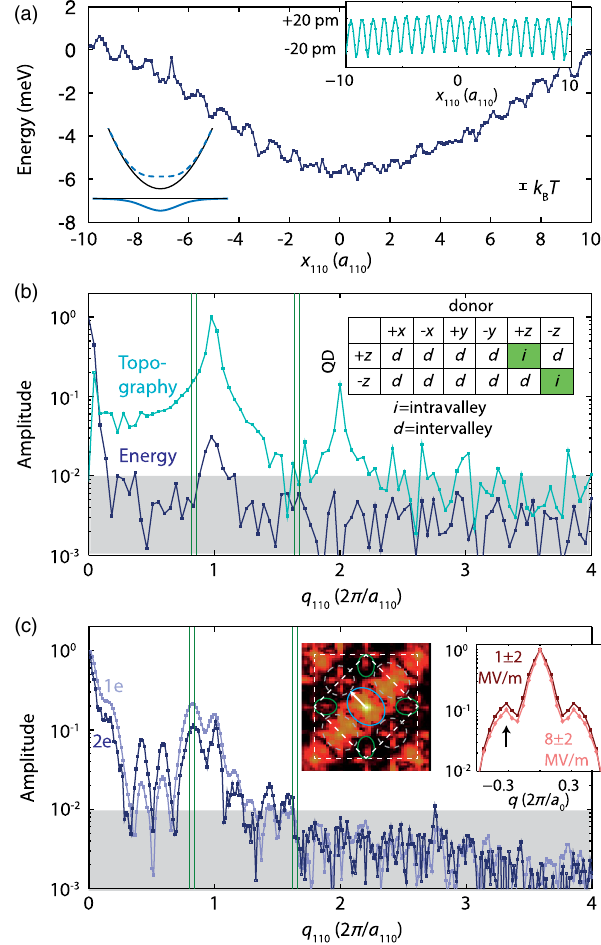
E ð x 0 Þ as a function of tip position x . Inset: Measured topography. (b) Spatial Fourier decomposition of E ð x 0 Þ where lattice-aperiodic components are less than 1% of value at q 110 ¼ 0 . Inset: Intravalley (green) and intervalley (white) tunneling for donor and QD. (c) One-dimensional spatial Fourier decomposition of 2 e and 1 e tunneling current along a ½ 110 (cid:4) direction, with lattice-aperiodic oscillations due to valley super- positions in donor bound states at q 110 ¼ 0 . 85 ð 2 π =a 110 Þ and ffiffiffi p 2 a harmonics, where a 110 ¼ 0 . Left-hand inset: Two- dimensional Fourier decomposition of one-electron tunneling probability at electric field 8 (cid:1) 2 MV = m and bias V ¼ − 1 . 010 V. Right-hand inset: Line cut through two-dimensional decomposition evidencing negligible valley repopulation of donor just below the 2 e